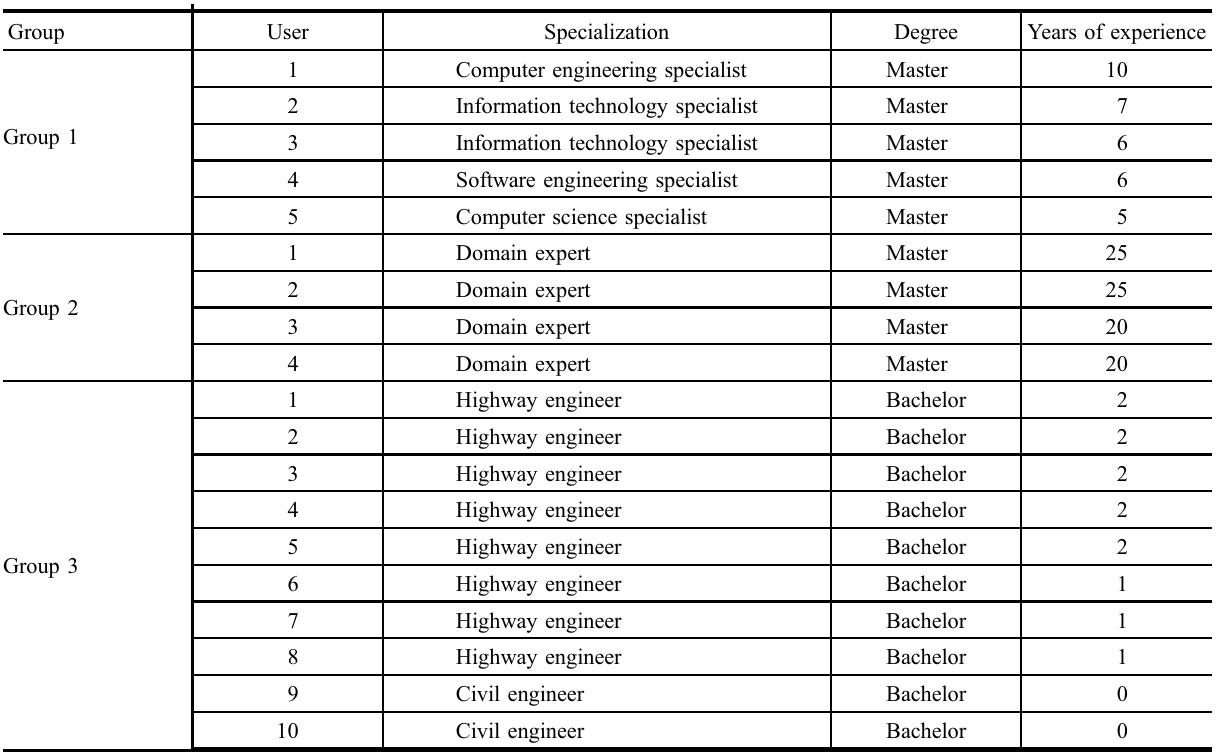
Table 4. Backgrounds of the users involved in system testing Group